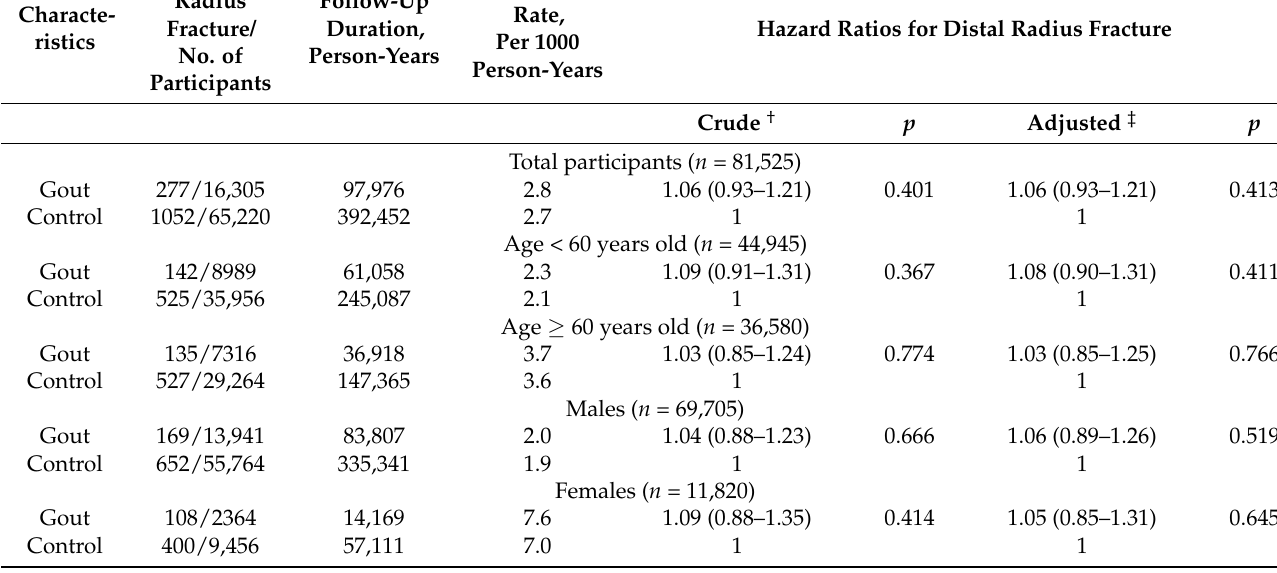
Table 3. Hazard ratio (95% confidence interval) for distal radius fracture in the gout and control groups with subgroup analyses according to age and sex.